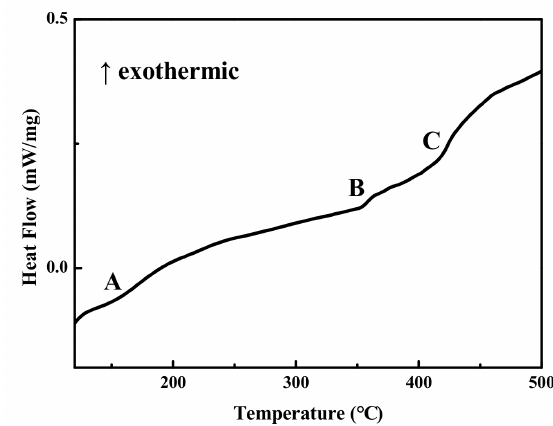
Figure 11. Di ff erential Scanning Calorimetry (DSC) result from the as-cast 1.6Li alloy within the temperature range 100–500 ◦